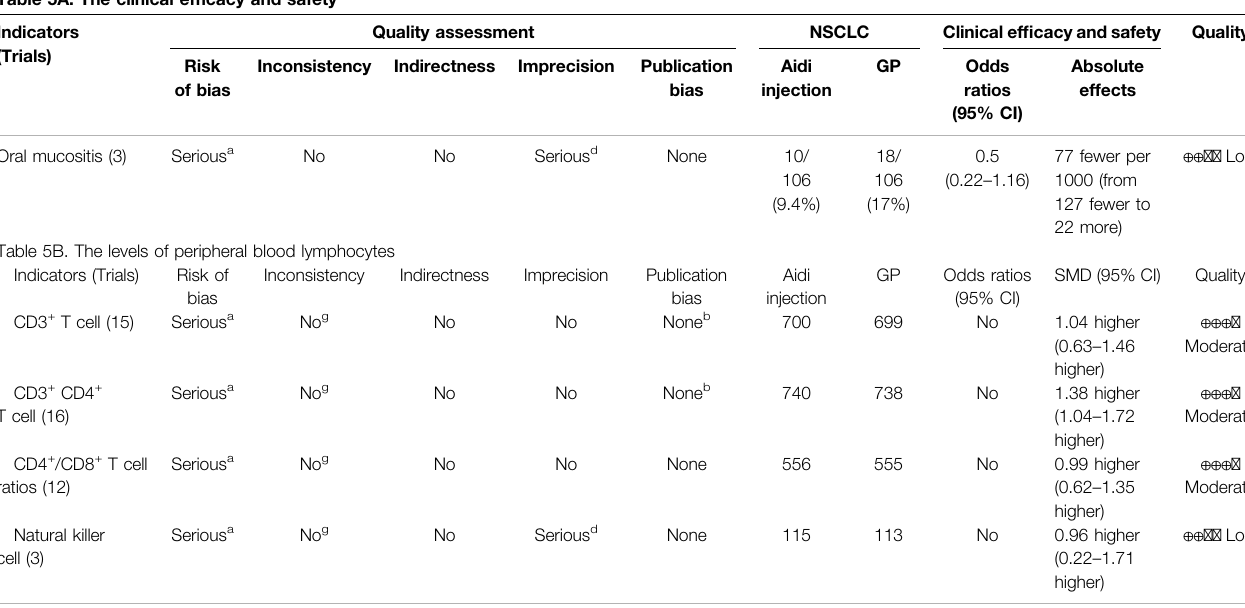
TABLE 5 | ( Continued ) GRADE evidence pro fi le. Table 5A. The clinical ef fi cacy and safety Indicators (Trials)